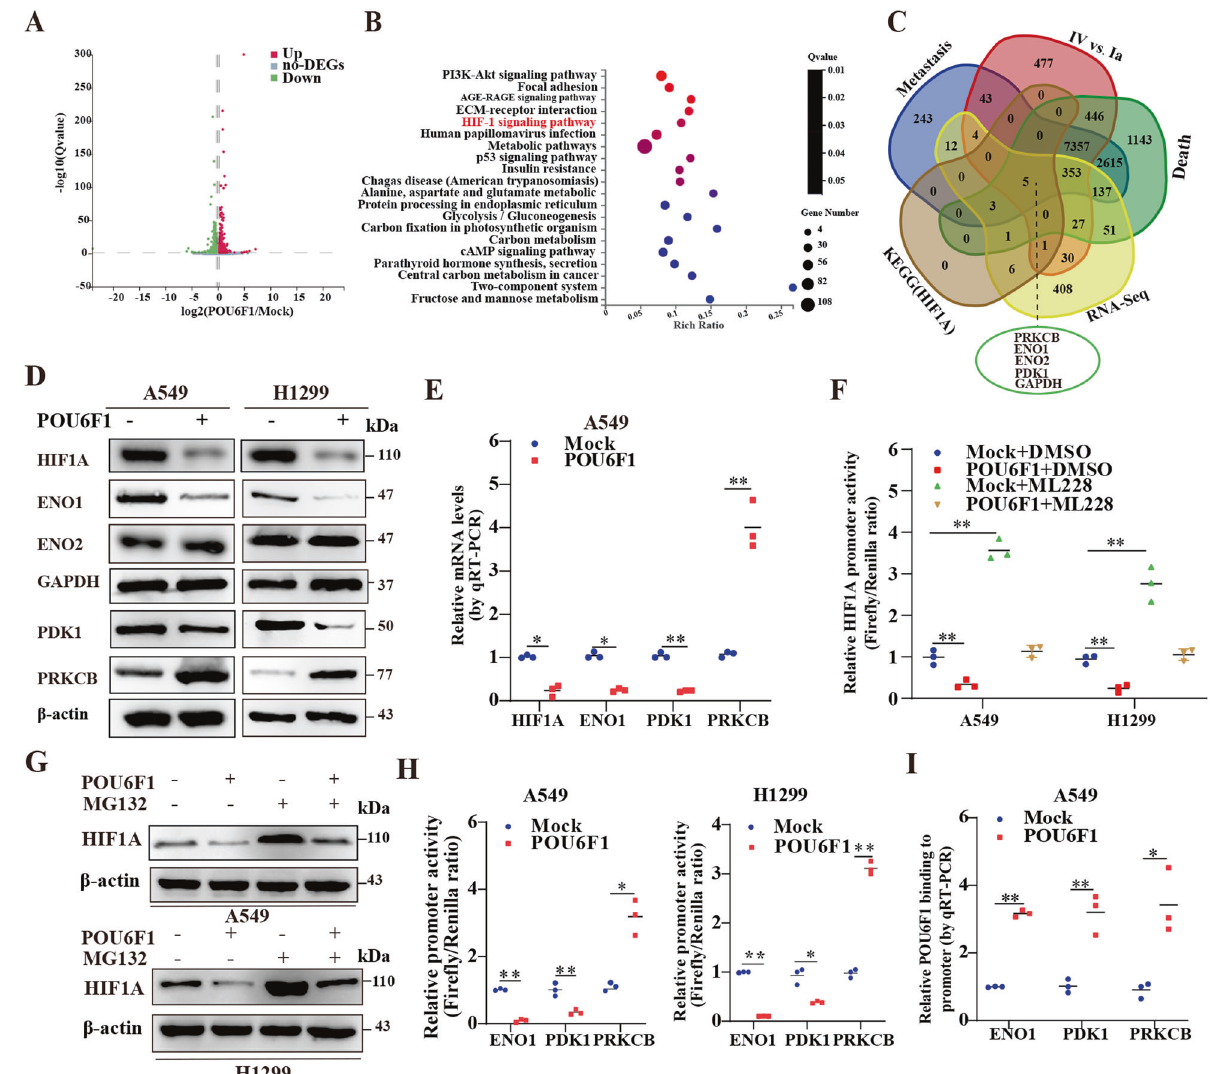
Fig. 5 POU6F1 inactivates HIF1A signaling pathway and transcriptionally regulates ENO1, PDK1, and PRKCB expression. A Volcano plot showing differential expression genes (DEGs) in A549 cells stably transfected with POU6F1 compared with empty vector (mock). B Human KEGG pathway analysis of DEGs indicating participated pathways in A549 cells stably transfected with POU6F1 relative to mock. C Venn diagram revealing comprehensive analysis of genes, that were involved with the HIF1A signaling pathway and associated with LUAD progression in various status of death, tumor stage, and metastasis. D Western blotting assay showing the expression of HIF1A, ENO1, ENO2, GAPDH, PDK1, and PRKCB in A549 and NCI-H1299 cells stably transfected with mock or POU6F1. E Real-time qRT-PCR assay indicating the expression of HIF1A, ENO1, PDK1, and PRKCB in A549 cells stably transfected with mock or POU6F1. F Dual-luciferase assay indicating relative activity of HIF1A promoter in A549 and NCI-H1299 cells stably transfected with mock or POU6F1, and those treated with DMSO or ML228 (1.0 μ mol/l). G Western blotting assay showing the expression of HIF1A in A549 and NCI-H1299 cells stably transfected with mock or POU6F1, and those treated with DMSO or MG132 (5 μ mol/l) for 6 h. H Dual-luciferase assay showing relative activity of ENO1, PDK1, and PRKCB promoter in A549 and NCI-H1299 cells transfected with mock or POU6F1. I ChIP and qPCR assays indicating relative POU6F1 enrichment on ENO1, PDK1, and PRKCB promoter in A549 cells stably transfected with mock or POU6F1. Student t -test and ANOVA compared the difference in E , F and H , I . * P < 0.05, ** P <